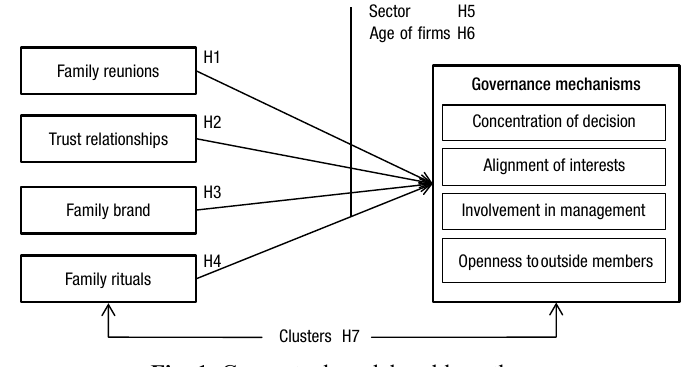
Fig. 1. Conceptual model and Table 1. Detailed information about the variables